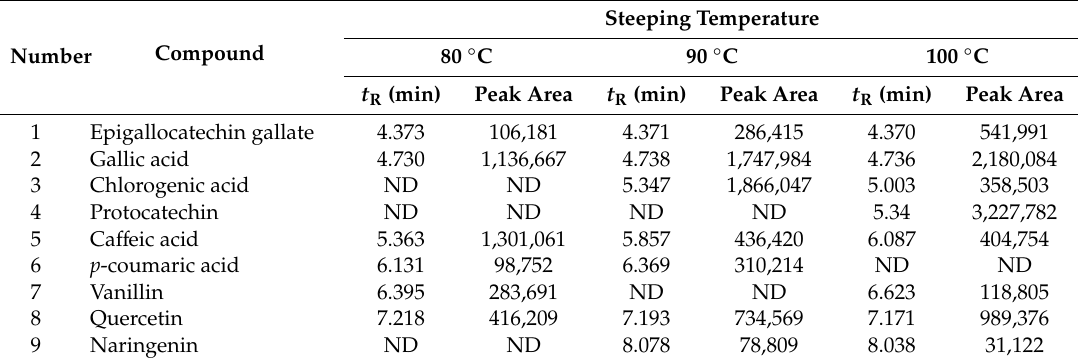
Table 3. Phenolic composition of infusions obtained from flowers and leaves of Cunila polyantha dried at 30 ◦ C for 48 h and prepared at di ff erent steeping temperatures (80, 90, and 100 ◦ C) identified by high-performance liquid chromatography